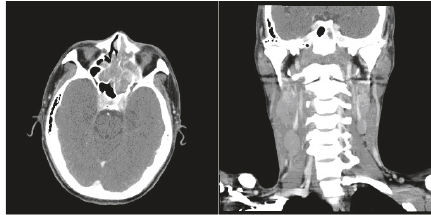
Figure 2: Contrast-enhanced CT of the head and neck reveals iso-enhancing masses in the left nasal cavity, nasopharynx, and paranasal sinuses, accompanied by bilateral neck lymphadenopathy.